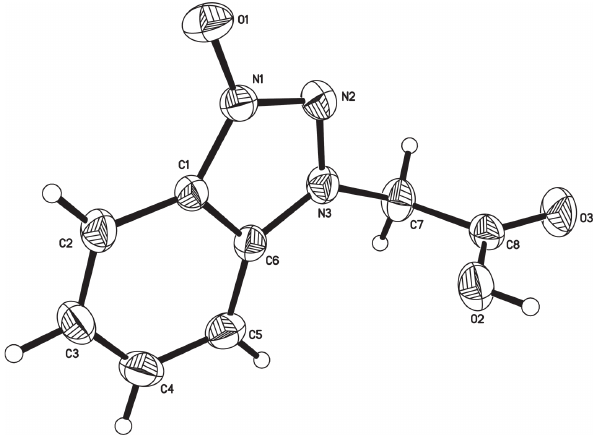
Table 2: Fractional atomic coordinates and isotropic or equivalent isotropic displacement parameters (Å 2